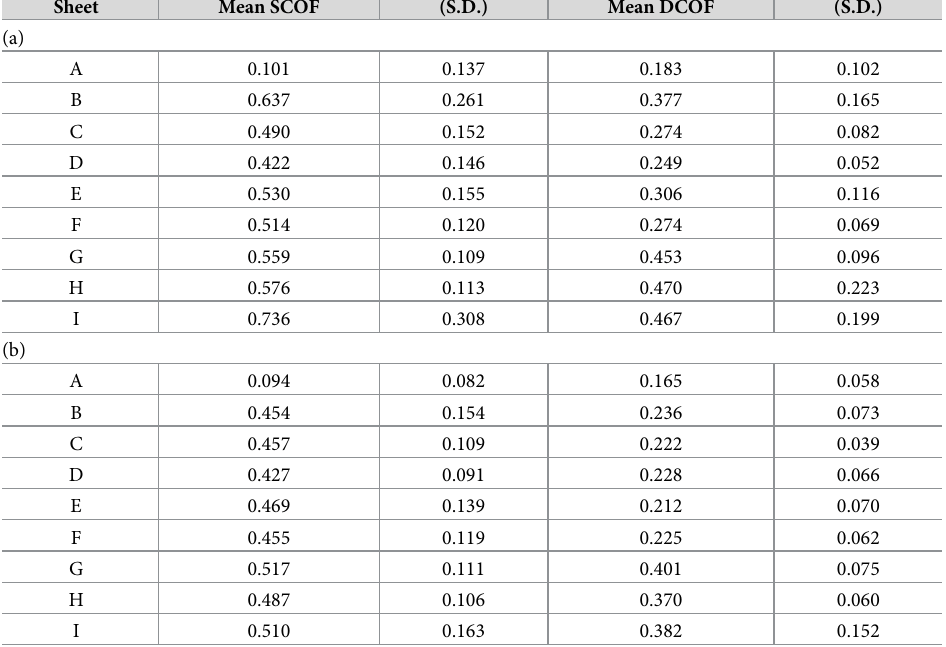
Table 5. Mean SCOFs and DCOFs between test sheets and test shoe for foot rubbing tests. (a) Standing position. (b) Sitting position.